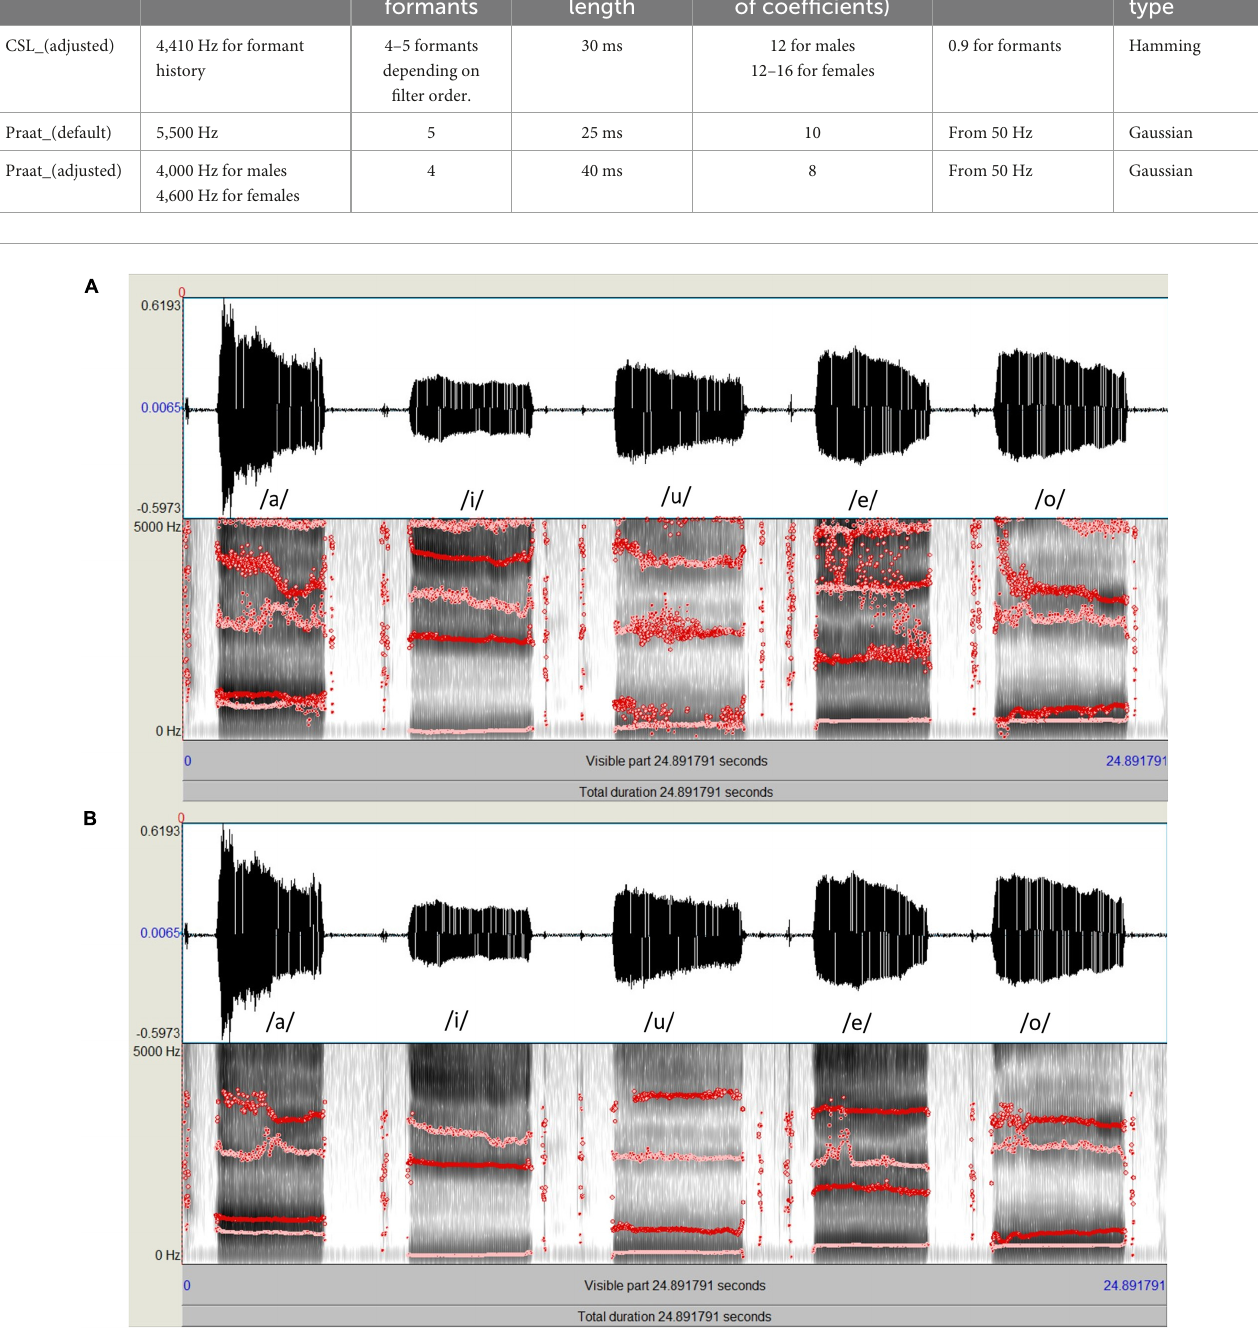
FIGURE1 Spectrograms and formant tracks of the same speech sample of five Japanese vowels (a/i/u/e/o); ( A , Top) Formant analysis using Praat with the default settings. ( B , Bottom) Formant analysis using Praat with adjusted settings, which resulted in more stable formant